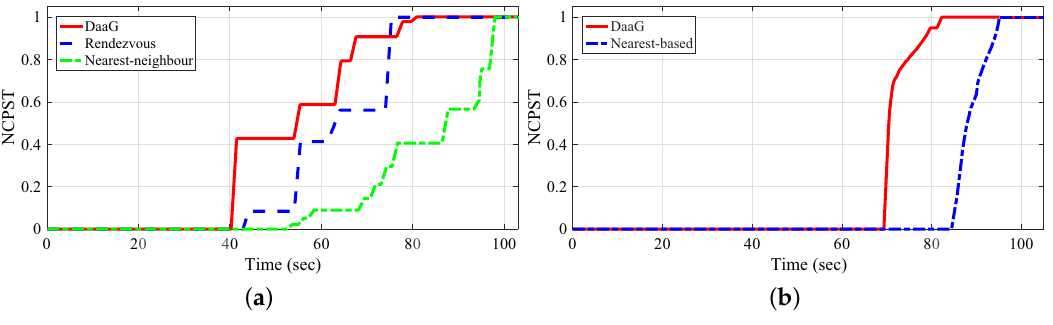
Figure 4. Normalized cumulative priority service throughput. ( a ) Data ferry method; ( b ) multi-hop network